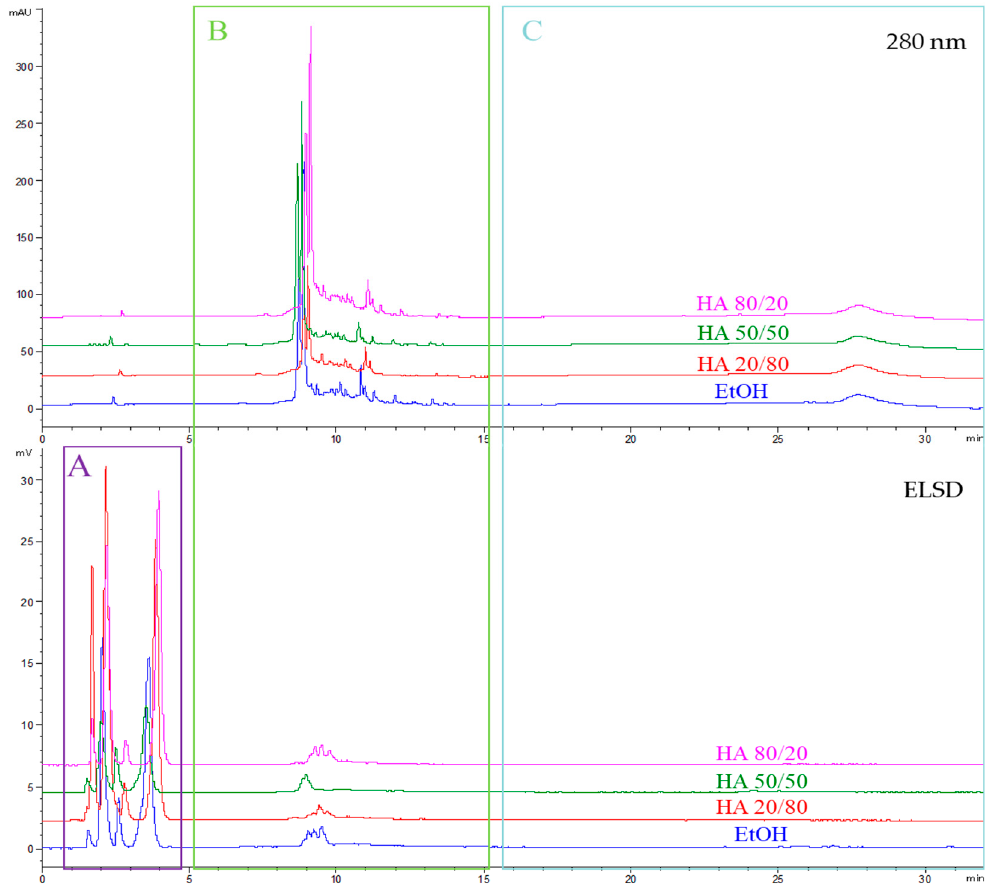
Figure 5. HPLC chromatograms obtained on a Luna ® C 18 column (150 × 4.6 mm; 5 µm) at 280 nm and with ELSD for the various R. nigrum pomace extracts obtained by conventional maceration (HA: hydroalcoholic, group A : polar molecules, group B : polyphenols, group C : terpenes, terpenoids and fatty acids).